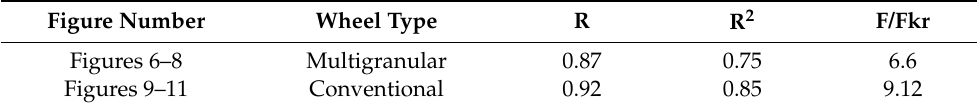
Table 7. Regression